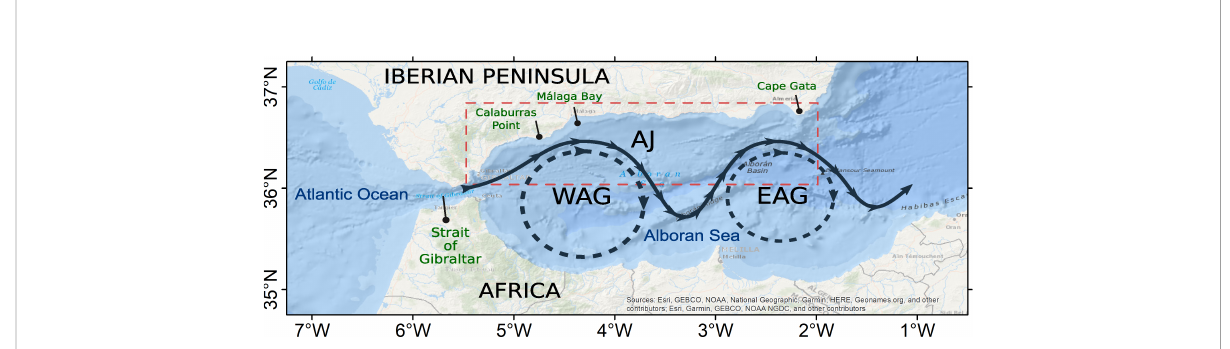
FIGURE 1 Simpli fi ed sketch of the study region and the Alboran Sea ocean dynamic. The area within the red box represents the so-called northern Alboran Sea (nAS). WAG and EAG refer to the so-called Western and Eastern Alboran Gyres, respectively, and AJ denotes the incoming jet of Atlantic